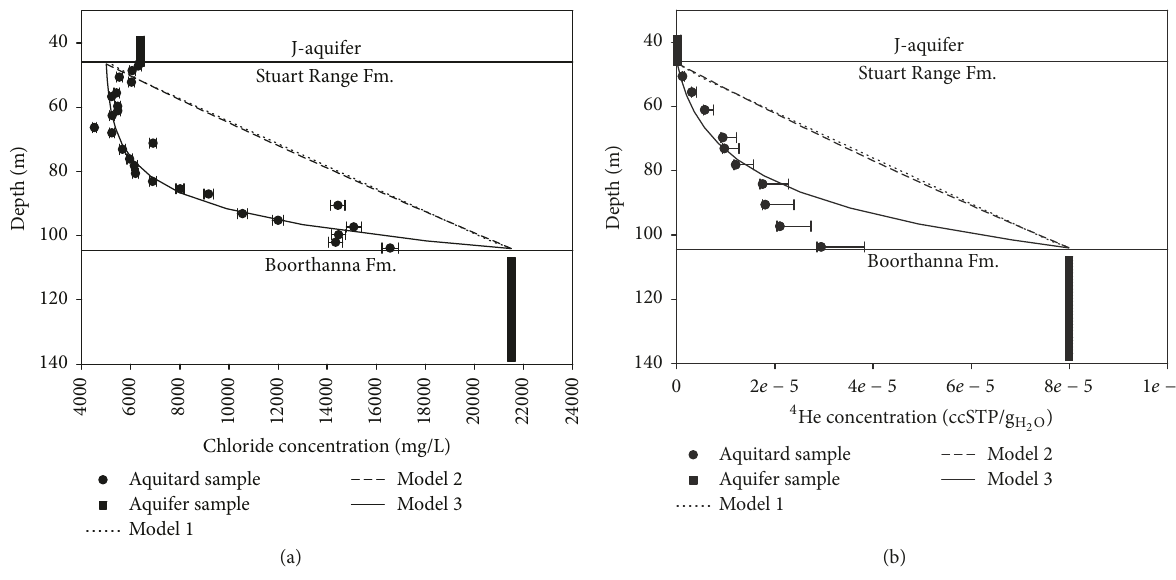
Figure 4: Profiles of (a) chloride and (b) 4 He concentrations. Circles indicate the pore water concentrations and the vertical bar represents the concentration in the aquifer, where the vertical length represents the screened interval. Error bars include total field, analytical errors, and, for 4 He, the 30% degassing loss during vacuum extraction (could be as high as 50% according to difference between measured and estimated Ne concentrations).Thedottedlinerepresentssteadystatesolutetransportanalyticalmodel1usingestimatedandcalculatedboundaryconditions from our core measurements but diffusion-only solute transport. The dashed line represents the steady state solute transport analytical model 2 using the estimated and calculated boundary conditions. The solid line represents the steady state solute transport analytical model 3 calibration of boundary conditions ( V 𝑧 and 𝐷 𝑒